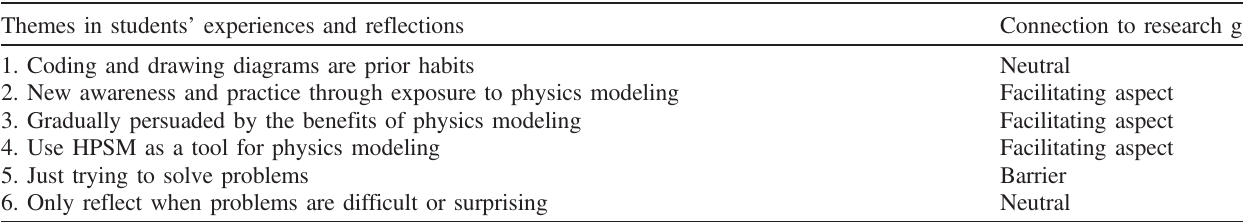
TABLE IV. Themes from students ’ experiences and reflections on the solutions structure and physics modeling. Themes in students ’ experiences and